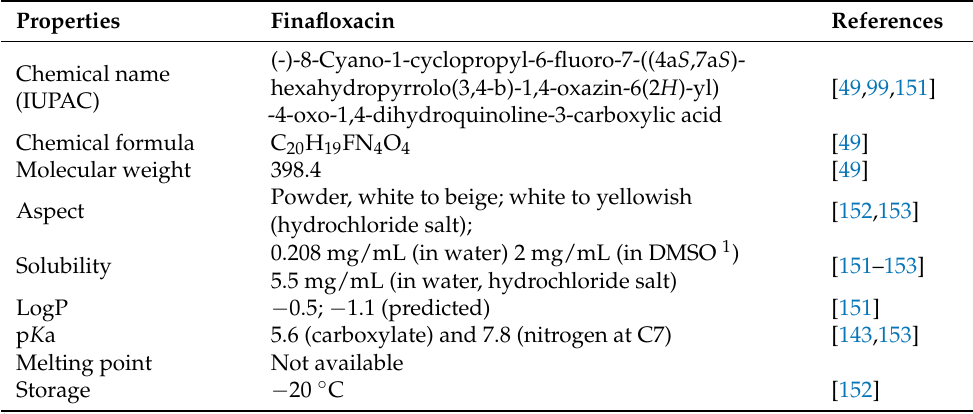
Table 5. Physicochemical properties of finafloxacin.